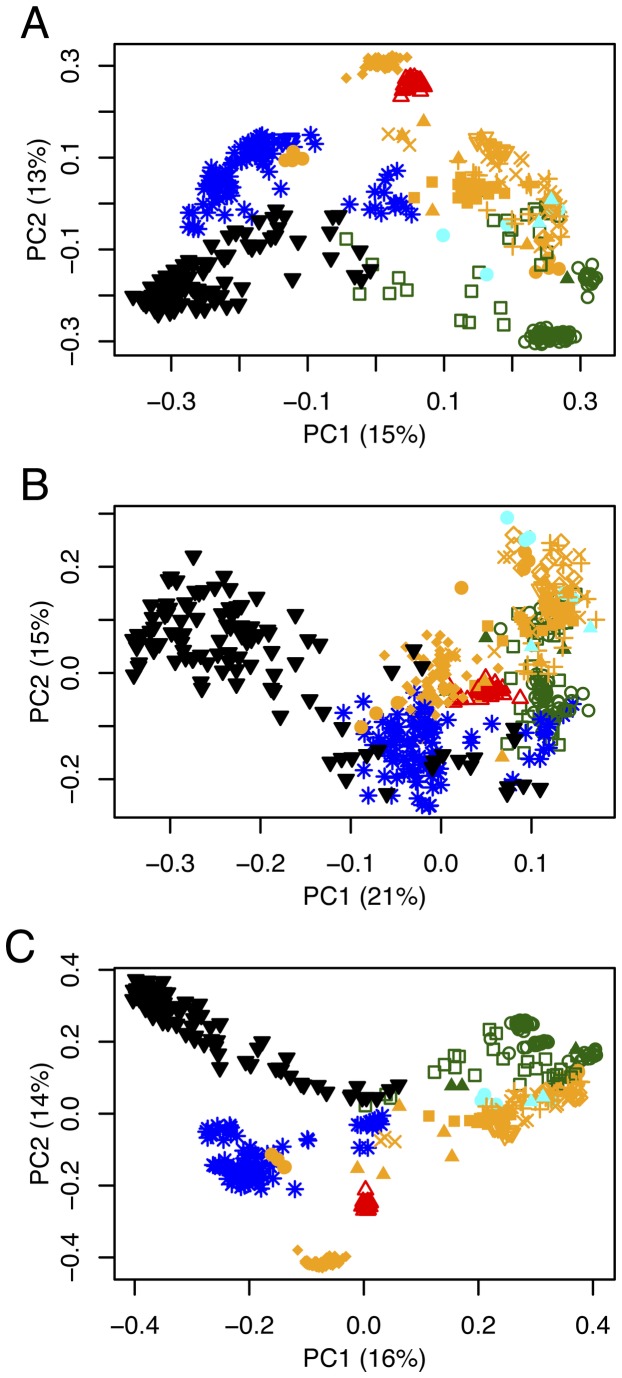
Principal coordinates plots of all Earth Microbiome Project sequenced soil samples based on unweighted UniFrac (A), weighted UniFrac (B), and Bray-Curtis (C) distances.The samples analyzed for this study are represented by open red triangles. All other samples are colored by biome: blue = polar desert, green = tundra, orange = temperate, black = warm desert, cyan = tropic. Filled triangles = EMP study 632, filled squares = 659, inverted open triangles = 722, inverted filled triangles = 1035, filled circles = 808, open diamonds = 1031, open squares = 1034, open circles = 1036, '+’s = 1037, 'X’s = 1038, and'*’s = 1526.